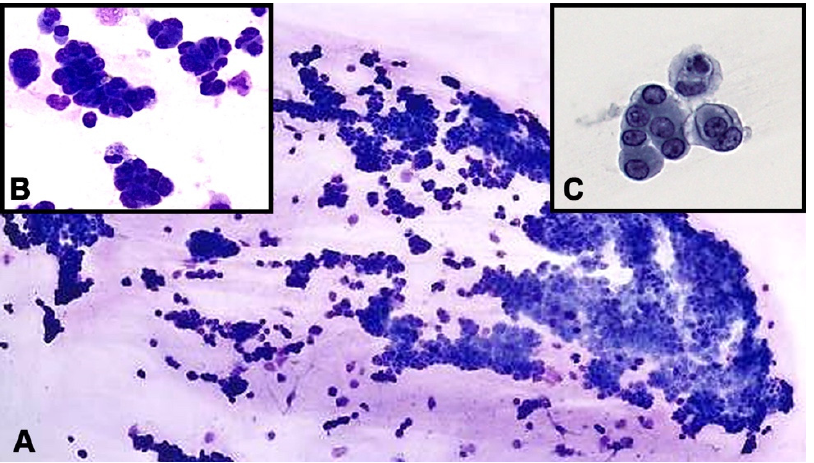
Figure 2. ( A ) . Hypercellular vitreous fluid demonstrating sheets of cohesive malignant epithelioid cells (Diff-Quik stain. Original magnification × 100). Inset ( B ) . Groups of tumor cells forming micropapilla-like structures (Diff-Quik preparation, × 400). Inset ( C ) . Pap-stained smear depicting clusters of neoplastic epithelioid cells with eccentric nuclei and vacuolated cytoplasm (original magnification × 400).